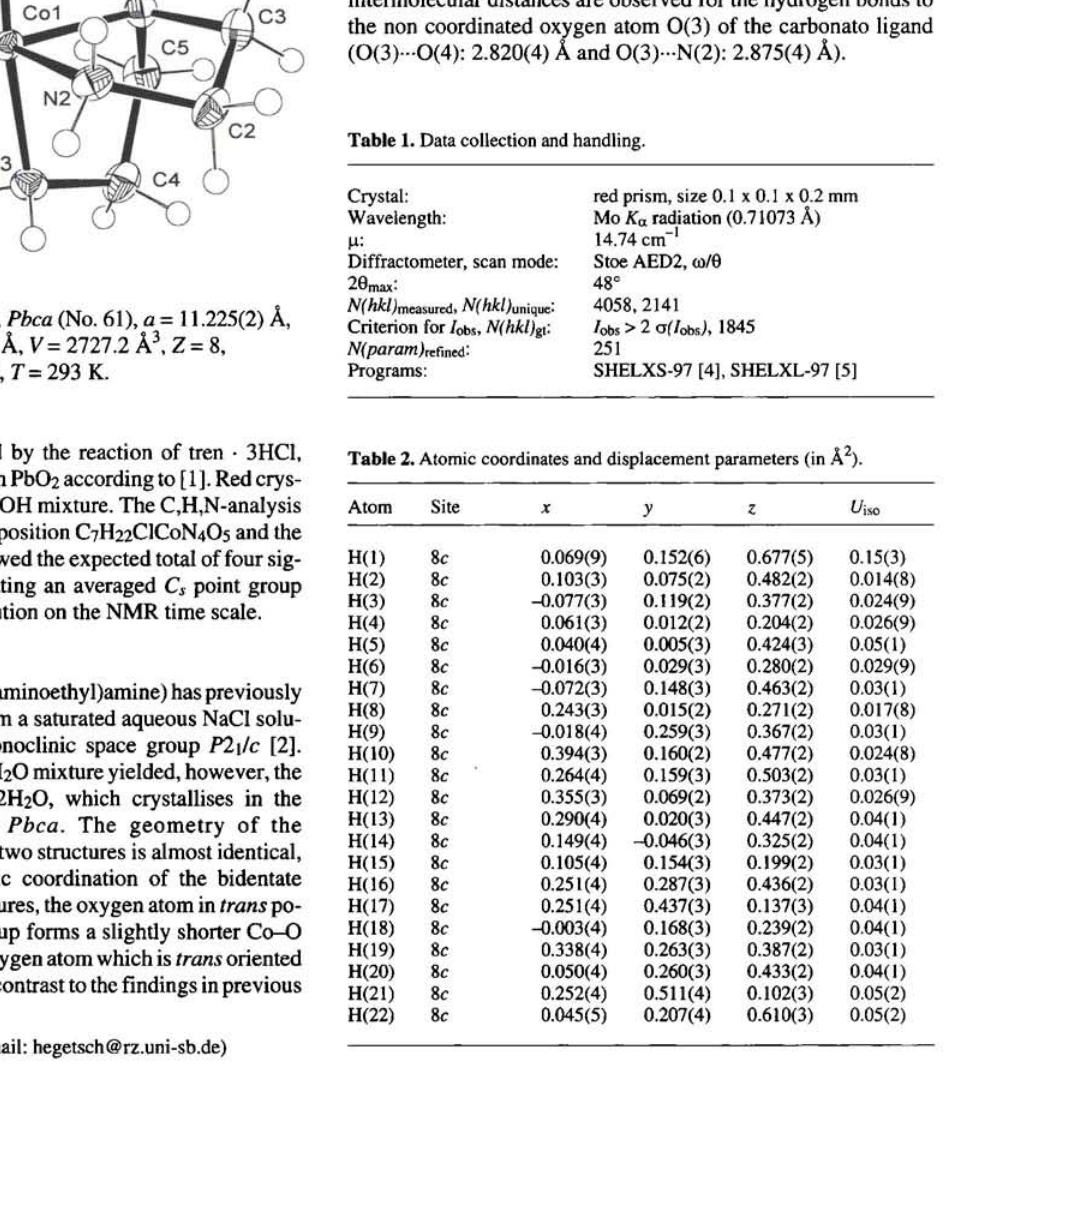
Table 1. Data collection and handling.